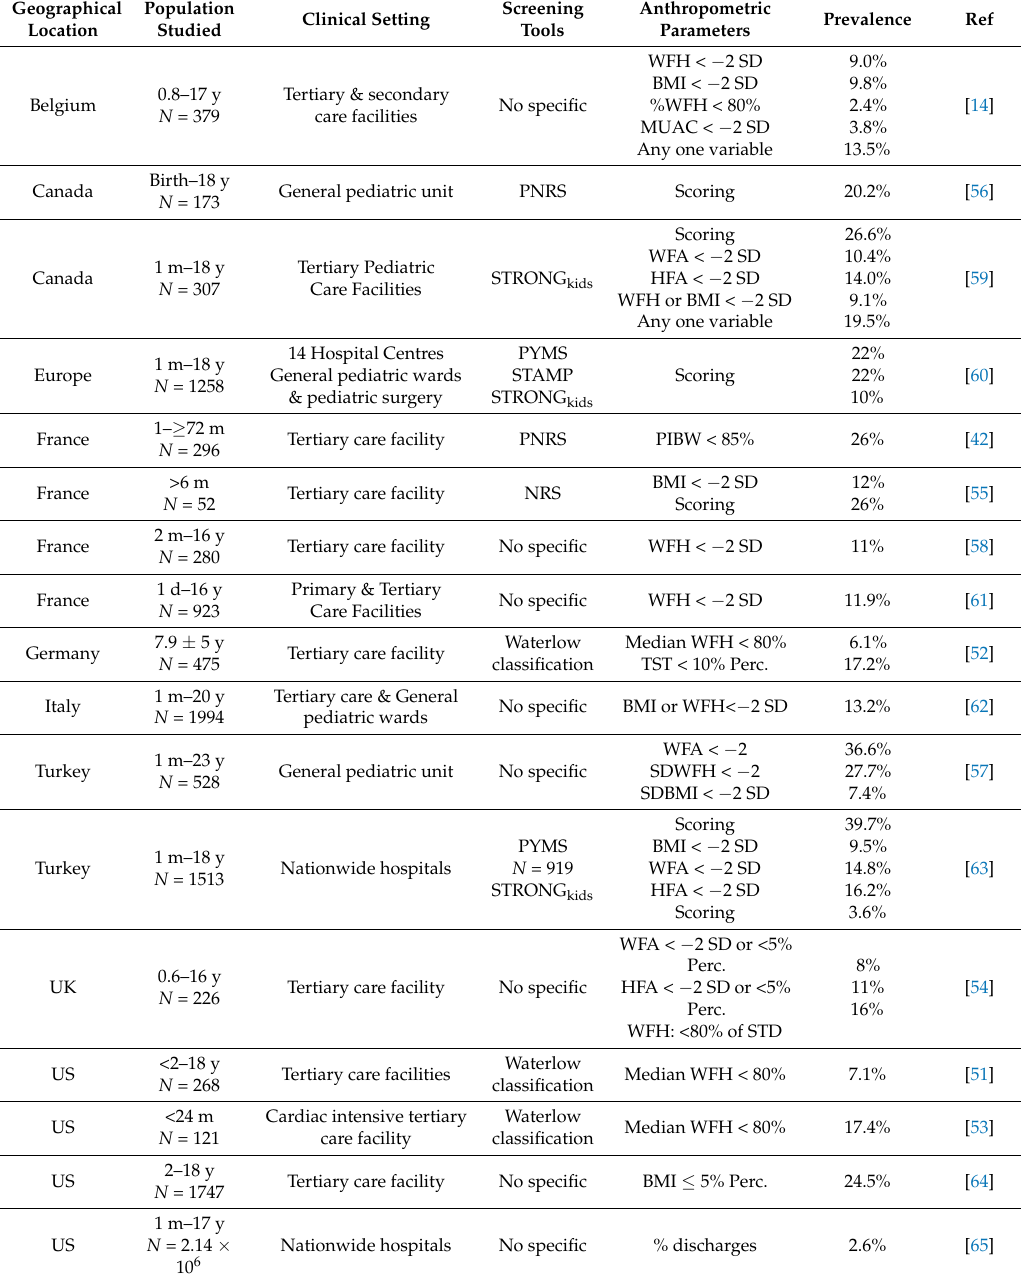
BMI: body mass index; WFH: weight for height (Waterlow classification, evaluation of acute protein-energy malnutrition, wasting); WFA: weight for age (acute, underweight); HFA: height for age (chronic stunting); Perc.: Percentile; PIBW: % of ideal body weight; MUAC: mid-upper arm circumference; TST: Triceps skinfold thickness; STD: standard deviation, d: day; m: month; y: